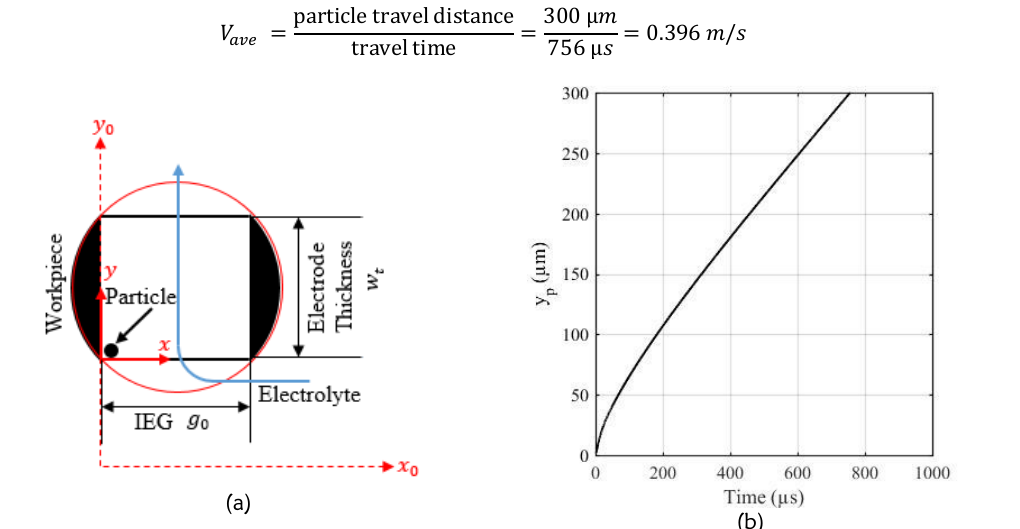
Figure 6 Particle movement in y-direction. Vibration 40 Hz at 10 µm, electrolyte flow rate 4